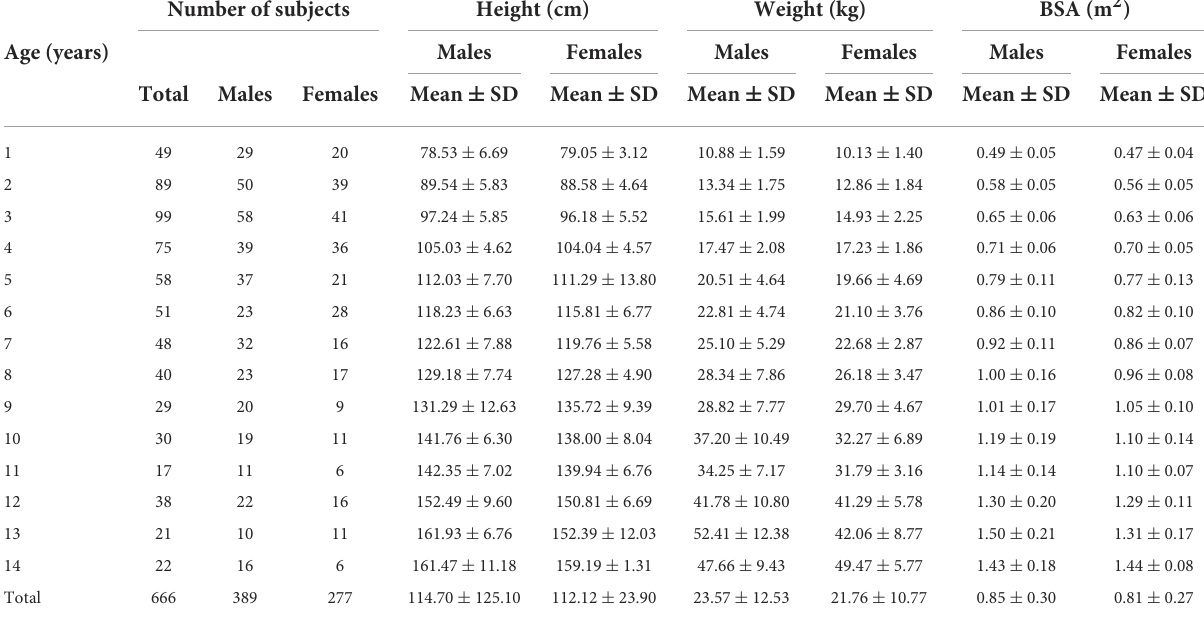
TABLE 2 Number of subjects, height, weight and mean BSA values.